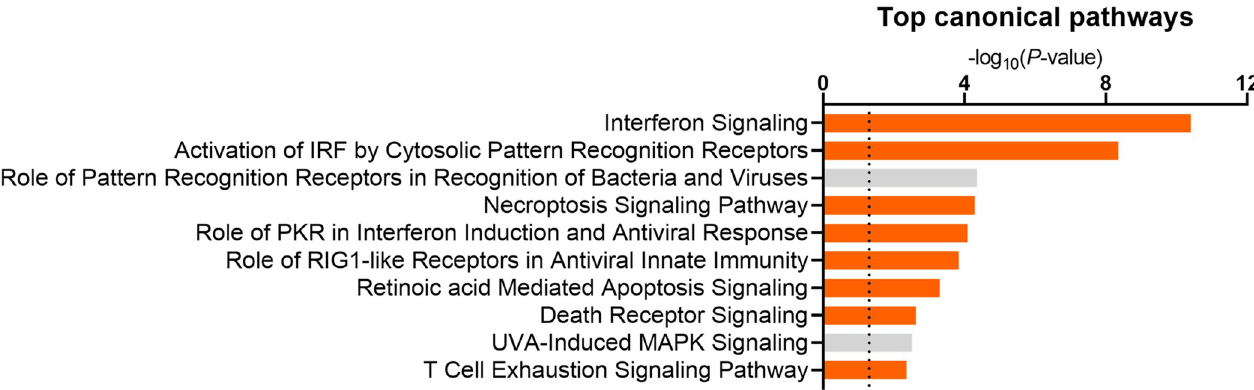
Fig 2. Canonical pathways regulated by pregnancy in cows after intrauterine infusion of pathogenic bacteria.